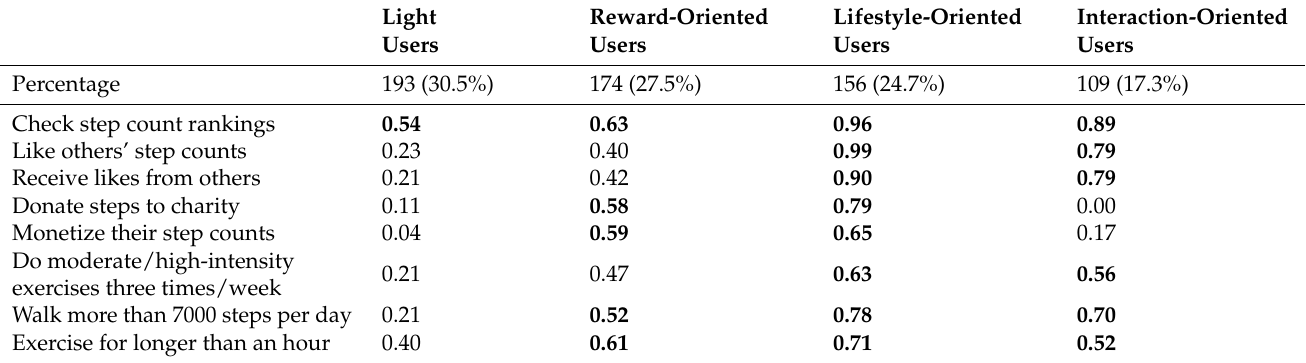
Figure 1. Conditional item response probabilities for the eight behavioral items in both classes. Table 4. Item-response probabilities for the four-class model, given latent class